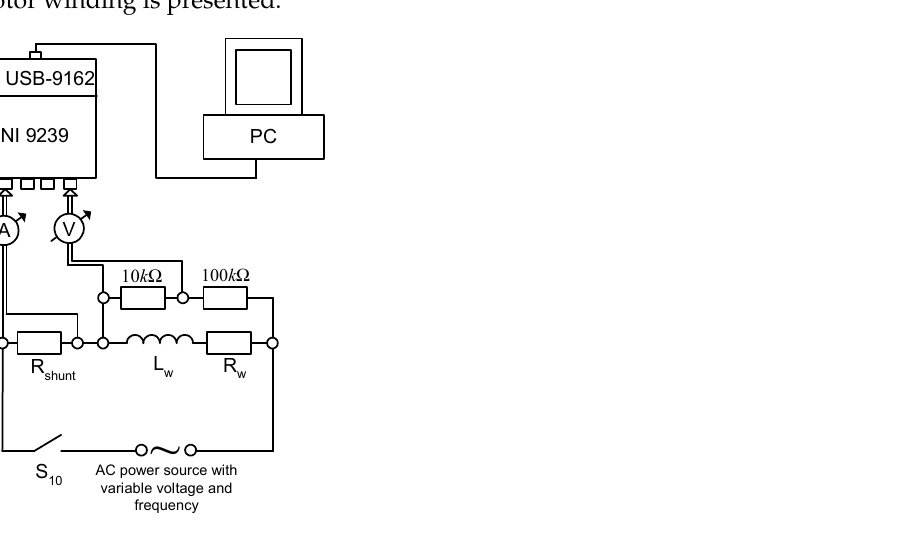
Figure 17. Experimental setup for measuring the self-dynamic inductance of a motor winding.